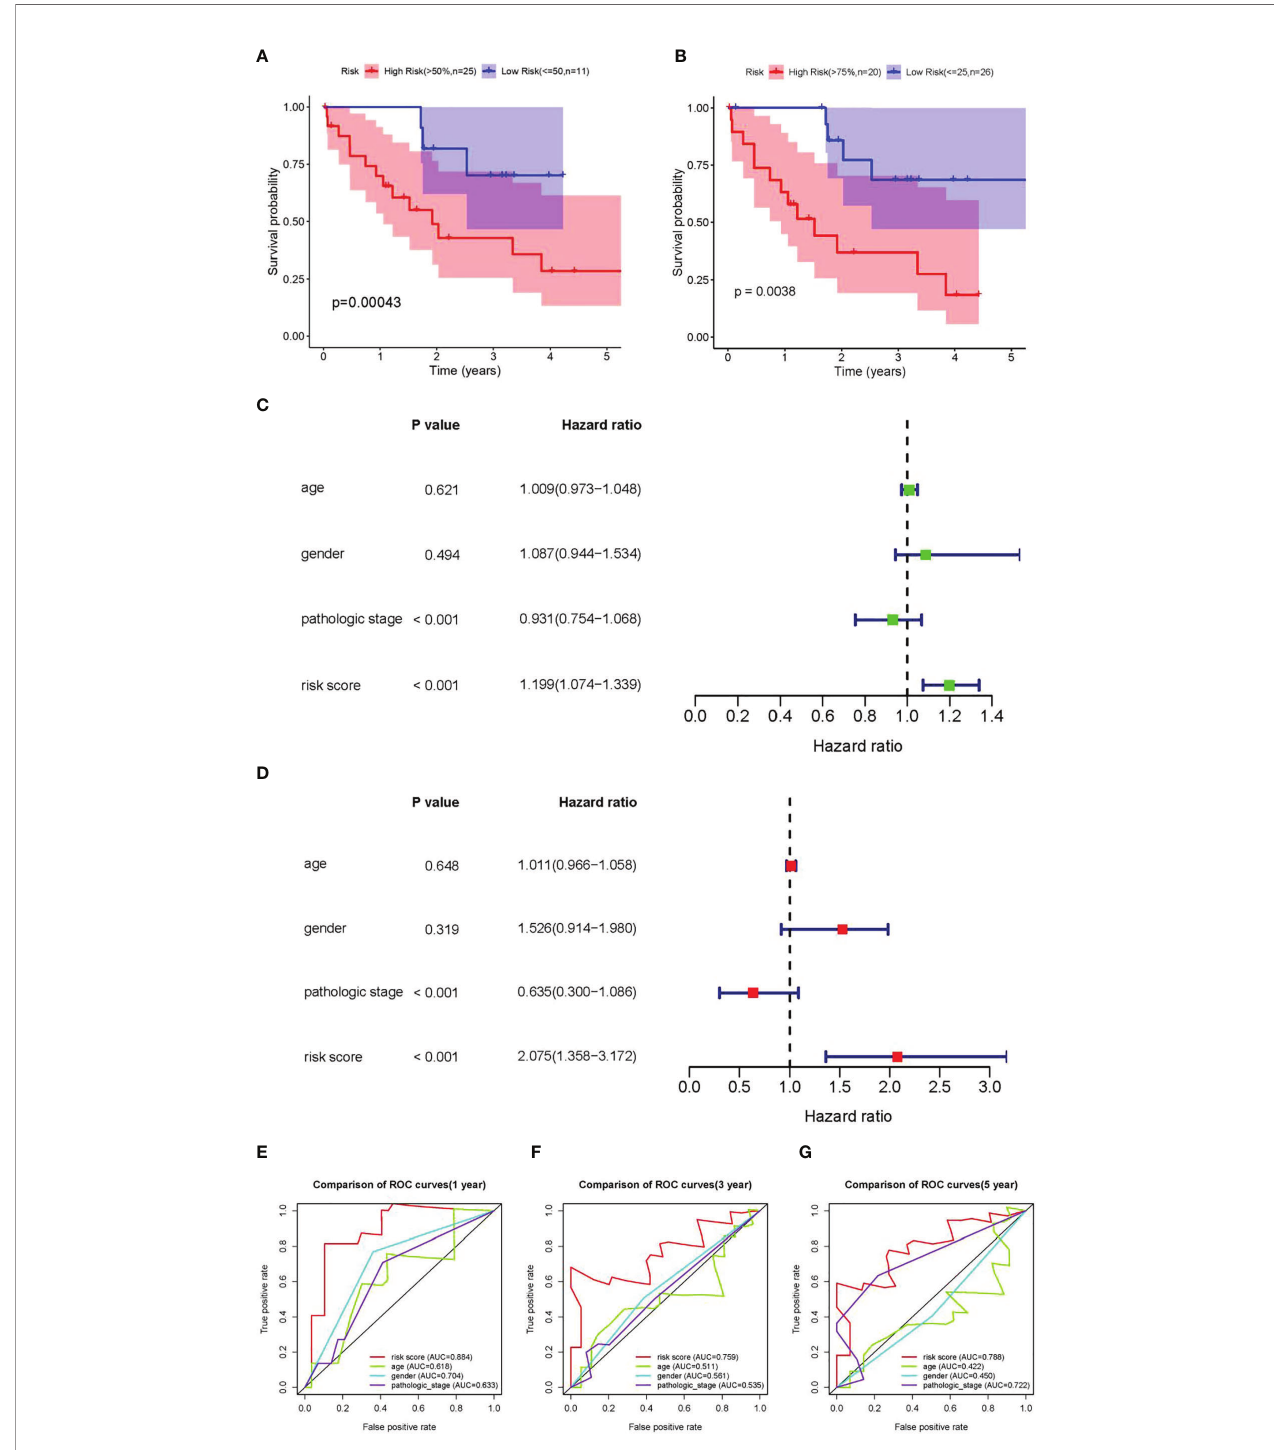
FIGURE 4 | Validation of the prognostic DEARlncRNA signatures of CHRM3.AS2, MIR205HG, and LINC00661. (A) The K-M curve analysis in high-risk (>50%) and low-risk ( ≤ 50%) patients. (B) The K-M curve analysis in high-risk (>75%) and low-risk ( ≤ 25%) patients. (C) Relationship of clinical characteristics and risk scores with OS of CCA patients presented by forest plot. (D) Relationship of clinical characteristics and risk scores with OS of CCA patients presented by forest plot. The 1-year (AUC = 0.884) (E) , 3-year (AUC = 0.759) (F) , and 5-year (AUC = 0.788) (G) time-dependent ROC curves.